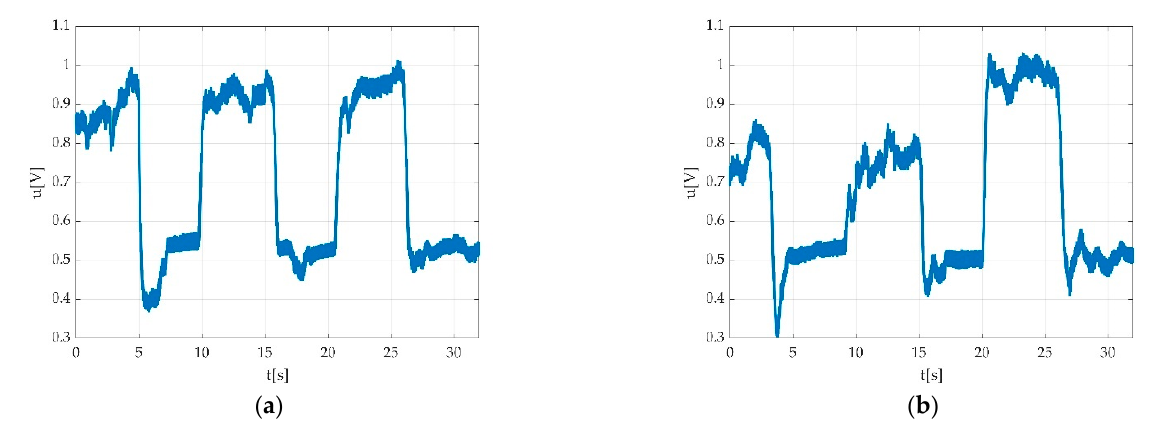
Figure 26. Example of invalid measurement rejected due to technical errors during ( a ) plantar flexion; ( b ) dorsiflexion.